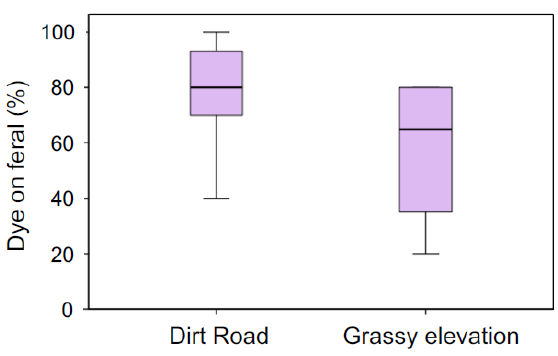
Figure 6. Box-plot of the percentages of fluorescent dye on feral receiver plants placed either on the border to the dirt road or in the grassy elevation.